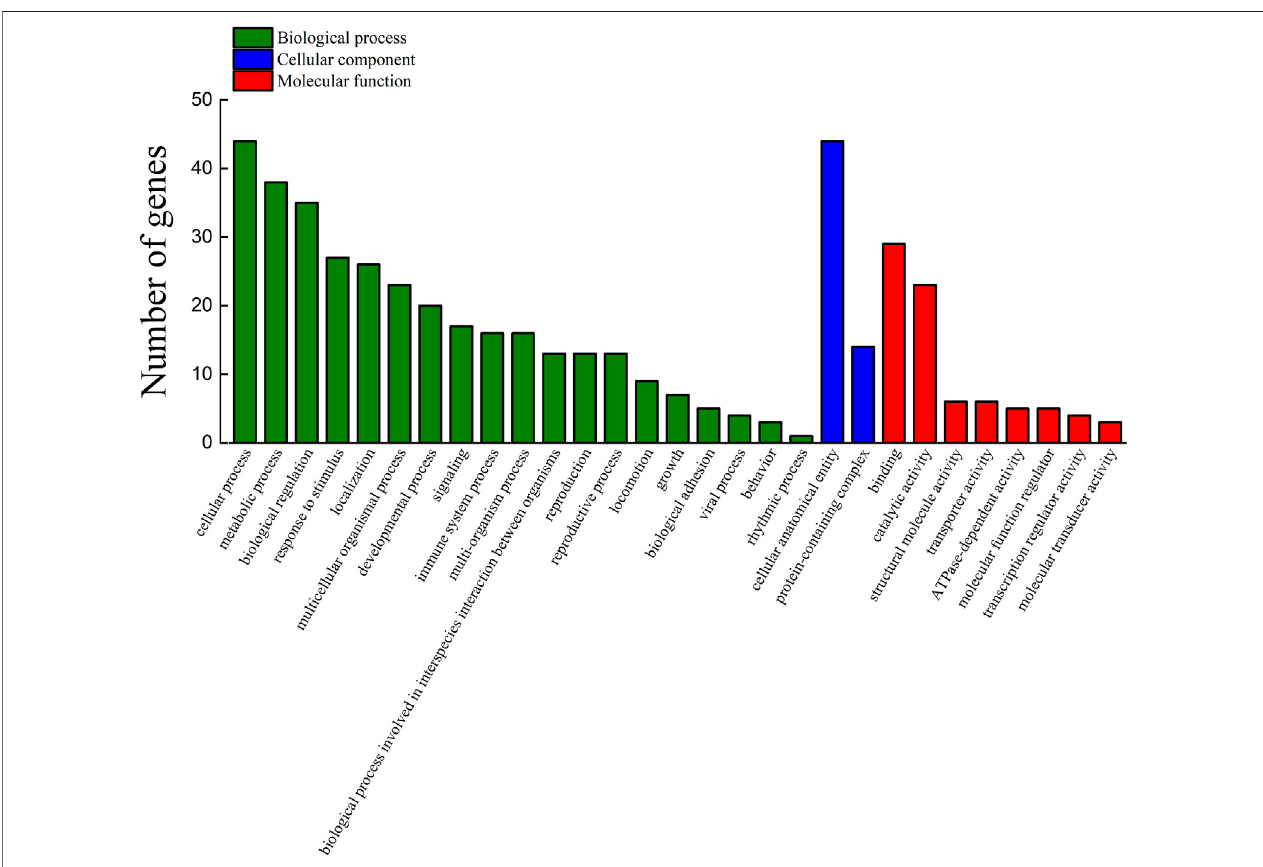
FIGURE 7 | Functional annotation of DEGs in the GO database. The counts of DEGs (differentially expressed genes) matched in level 2 GO (Gene Ontology) categories. The x-axis indicates 29 levels 2 GO categories. The y-axis indicates the number of DEGs that were matched.